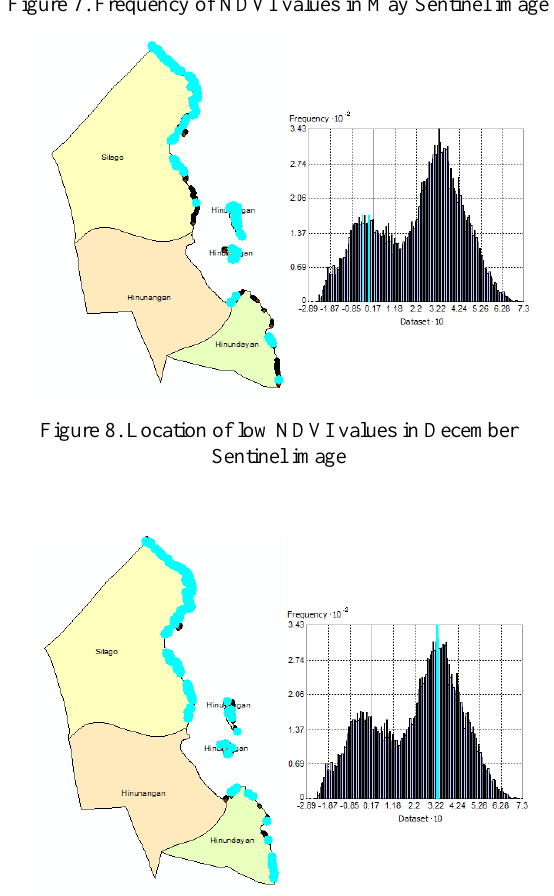
Figure 7. Frequency of NDVI values in May Sentinel image